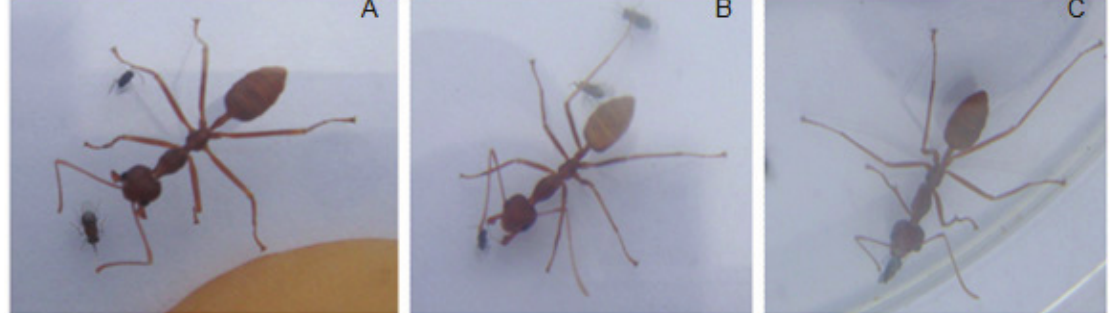
Figure 5. Oecophylla longinoda worker aggressively targets a fast running parasitoid ( A ); destabilizes it using its antenna ( B ) and finally seized the wasp with its mandibles ( C ).